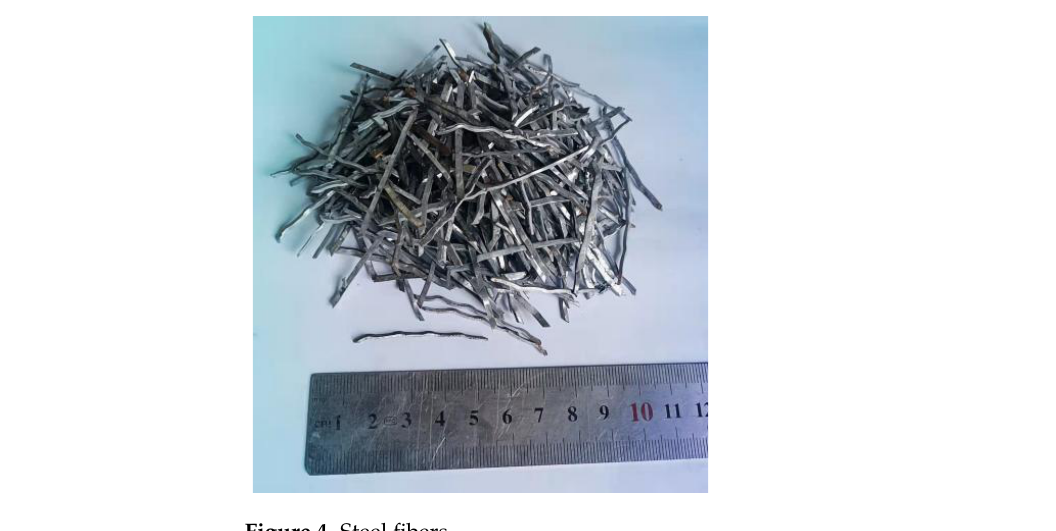
Figure 4. Steel fibers. Table 2. Physical and Chemical properties of cement.